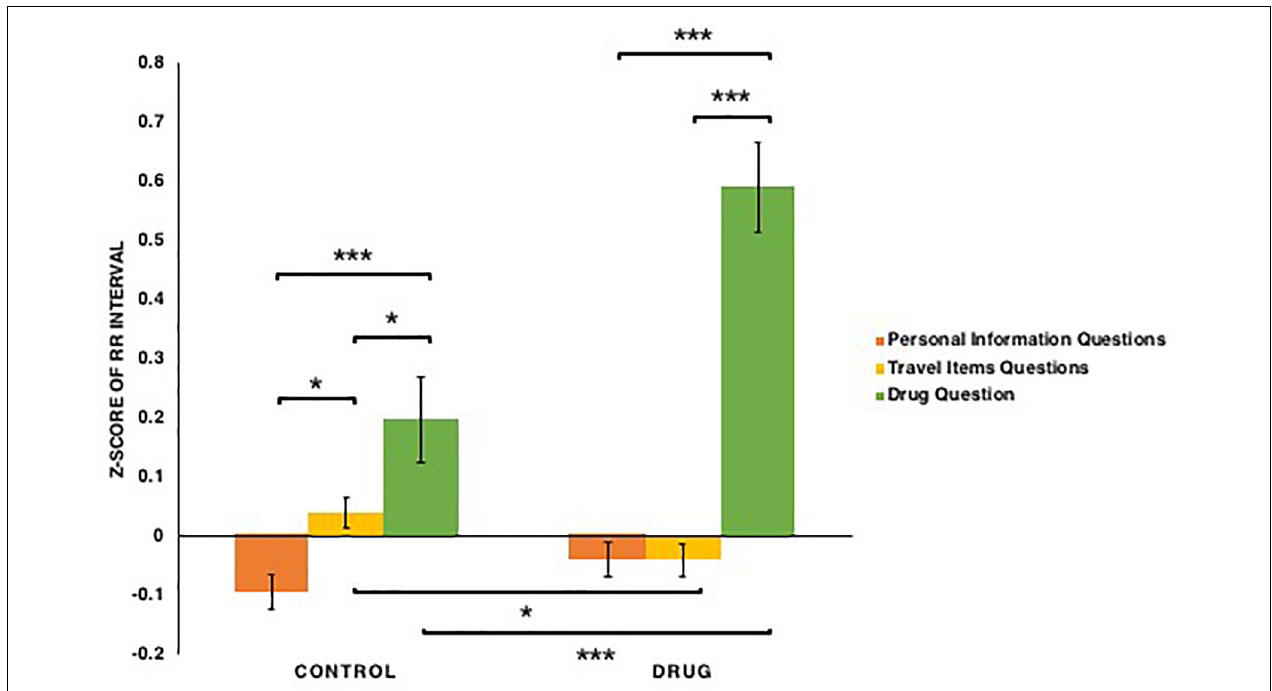
FIGURE 5 | The z -scores of the RR interval among participants in the control and drug conditions when answering three types of questions: basic personal information, carrying common travel items, carrying drugs. Note that ∗ p < 0.05, ∗∗ p < 0.01, ∗∗∗ p < 0.001. The error bars stand for standard errors